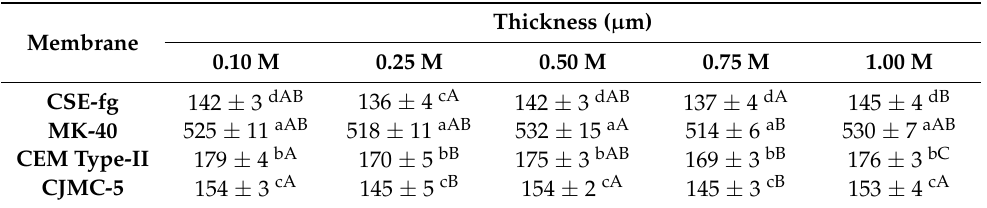
Table 3. The thickness of membranes according to NaCl